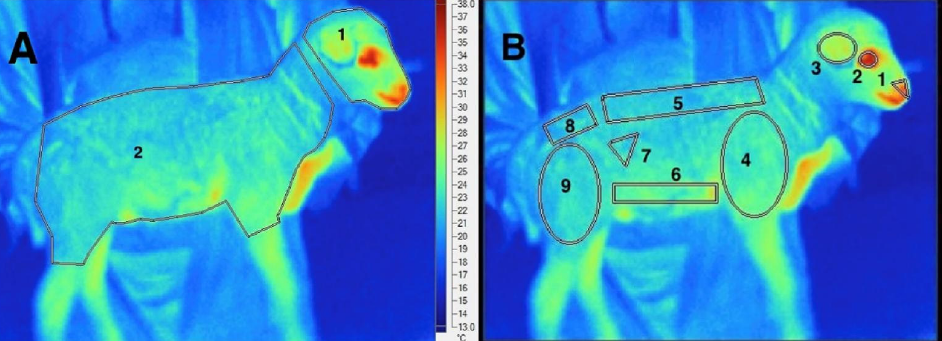
Figure 2. IRT imaging technology in the detection of animal core temperature fluctuation. Infrared thermography from neonatal lambs sectioned in different body sites: ( A ) (entire head (1) and entire body (2)) and ( B ) (muzzle (1), eye (2), ear (3), shoulder (4), loin (5), belly (6), right flank (7), rump (8) and leg (9)). Reprinted with permission from Ref. [71]. Copyright Elsevier and copyright clearance